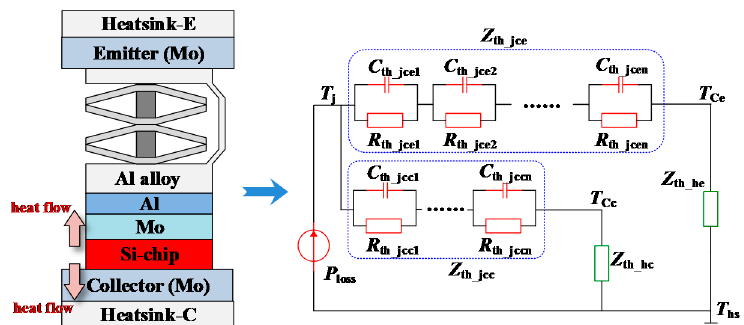
Figure 7. Equivalent thermal impedance of single press-pack IGBT chip under double-sided cooling condition.